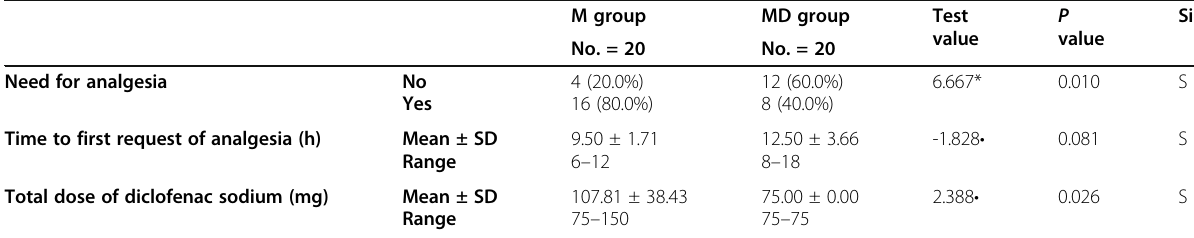
Table 3 Need for analgesia